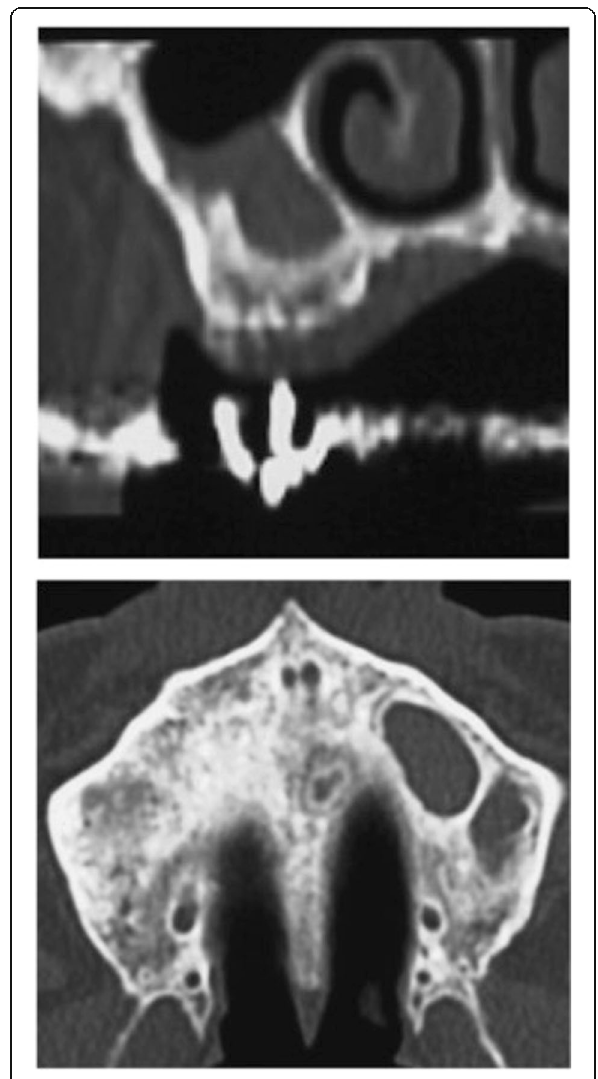
Fig. 2 Septa and thickened sinus membrane within maxillary sinus